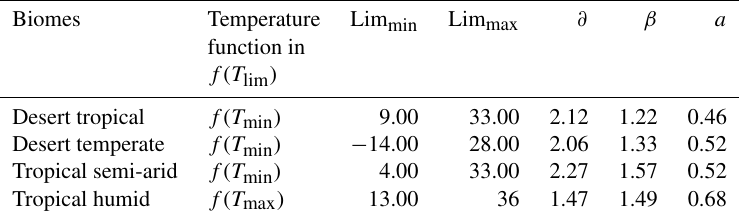
Table A2. Parameter values for maximum temperature f ( T max ) in Eq. (A1) and minimum temperature f ( T min ) in Eq. (A2). Biomes